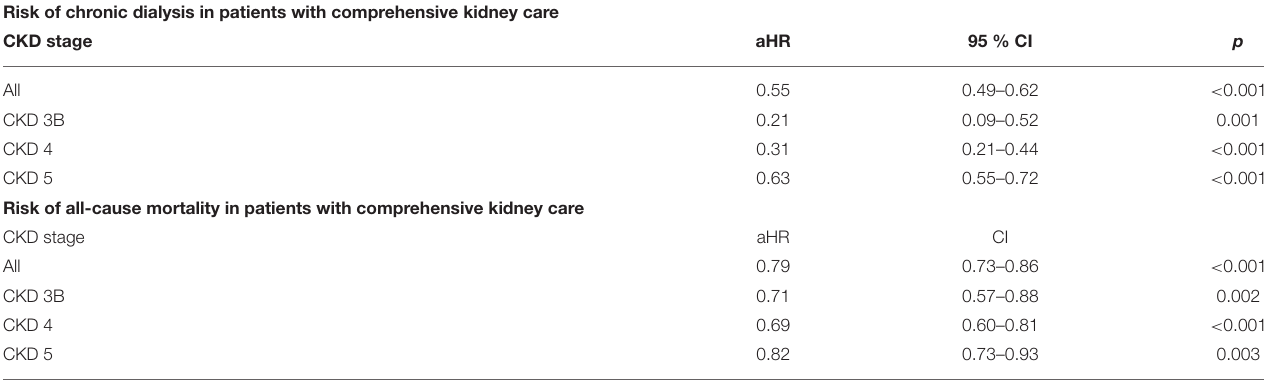
TABLE 3 | Risks of dialysis or all-cause